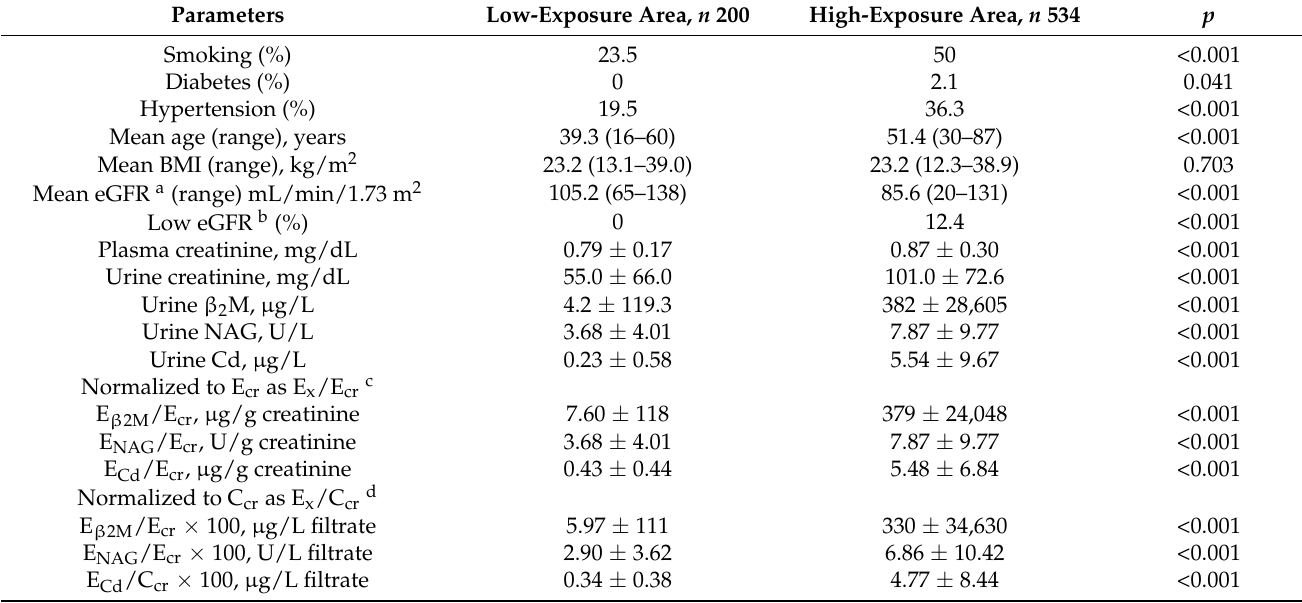
Table 2. Characteristics of study subjects, stratified by residential